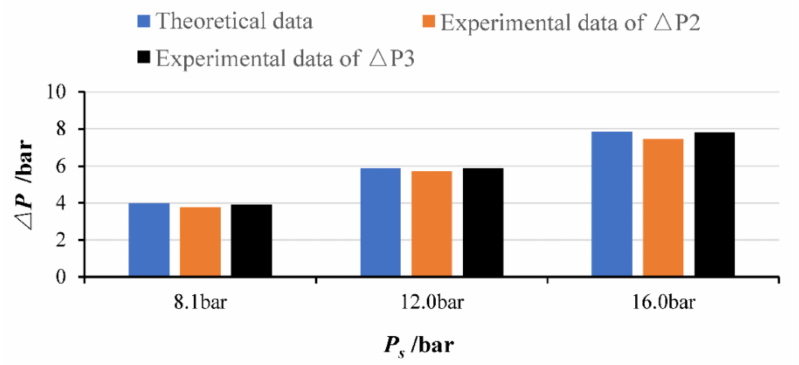
Figure 9. Comparison of pressure drop under different system pressure